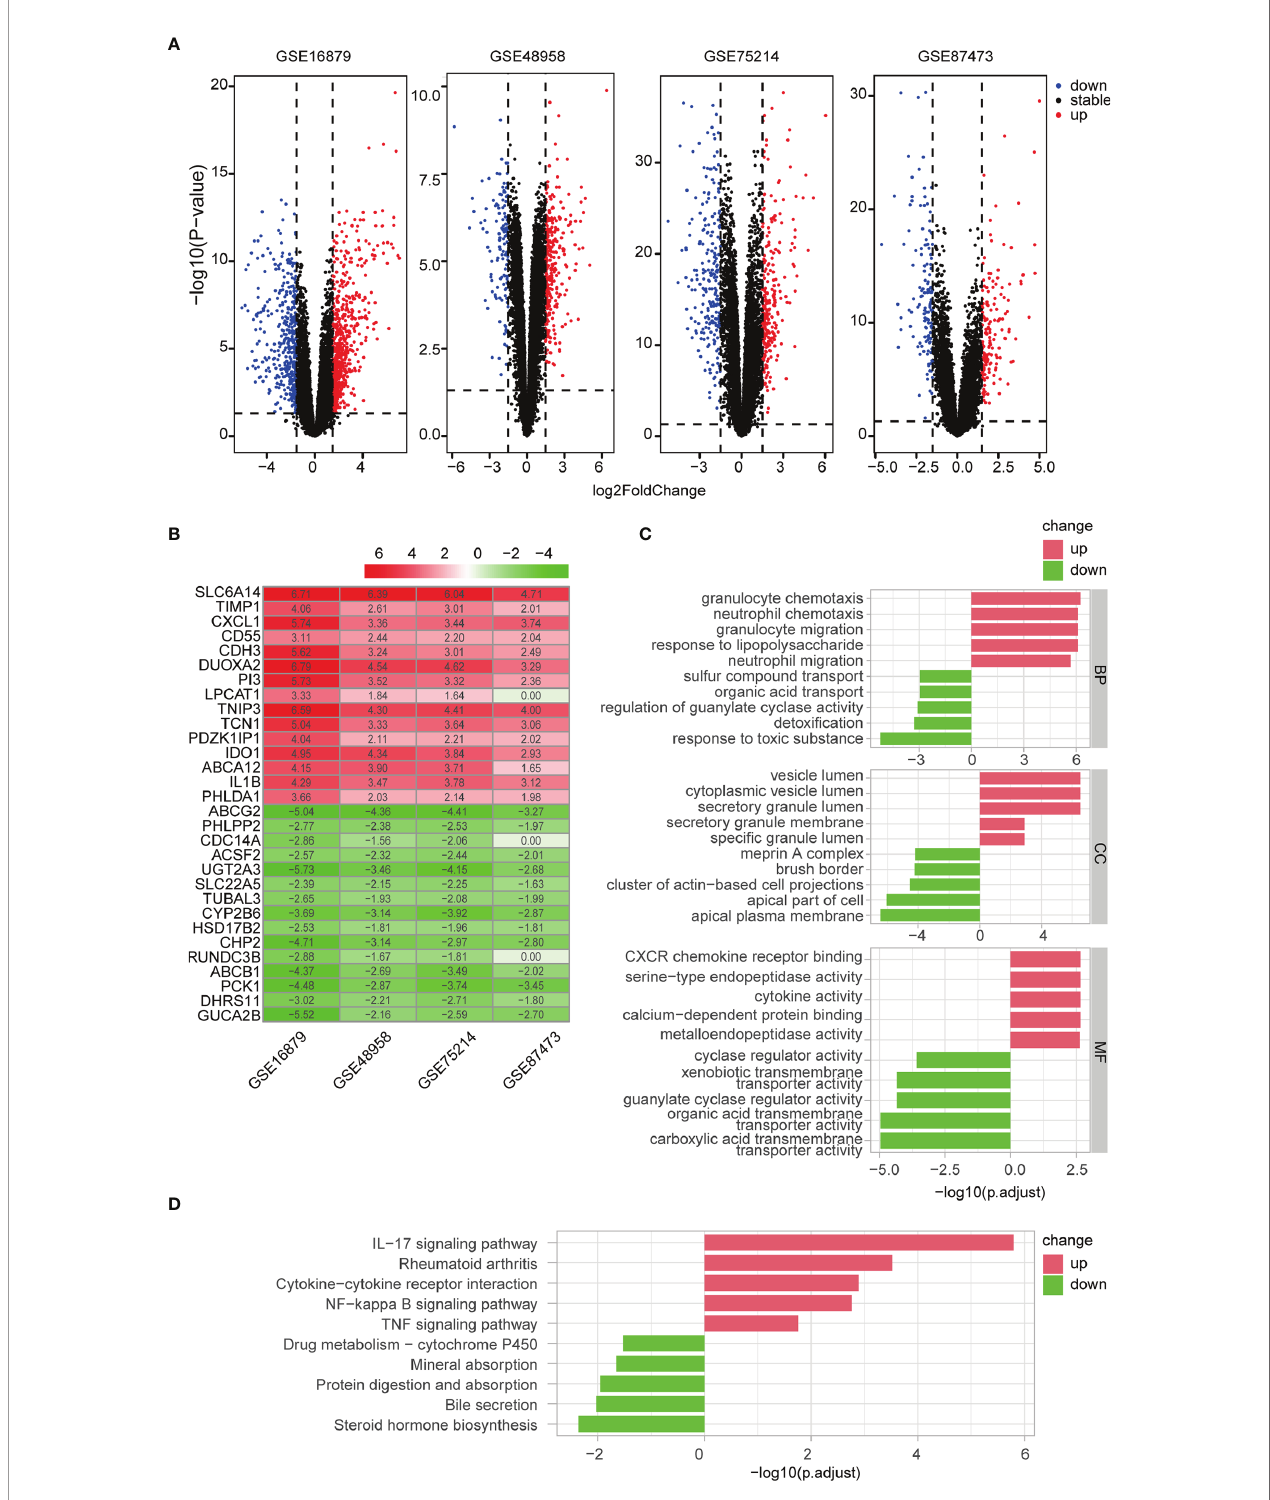
FIGURE 4 | Differentially regulated genes (DEGs) were identi fi ed via RRA analysis. (A) Volcano plots show DEGs in active UC and control samples from the four GEO datasets. (B) Heatmap of the top 15 up- and down-regulated DEGs from the integrated analysis. (C) GO functional enrichment analysis, including BP, CC, and MF, revealed the underlying functions of up- and down-regulated DEGs. (D) KEGG revealed the top ten pathways enriched in up- and down-regulated